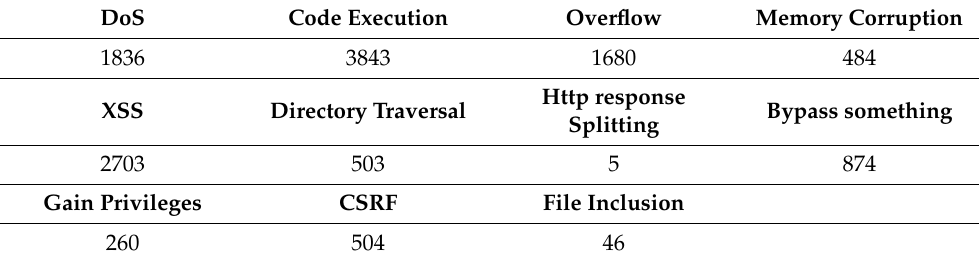
Table 3. Number of identifications by attack target that occurred in 2021 [32].